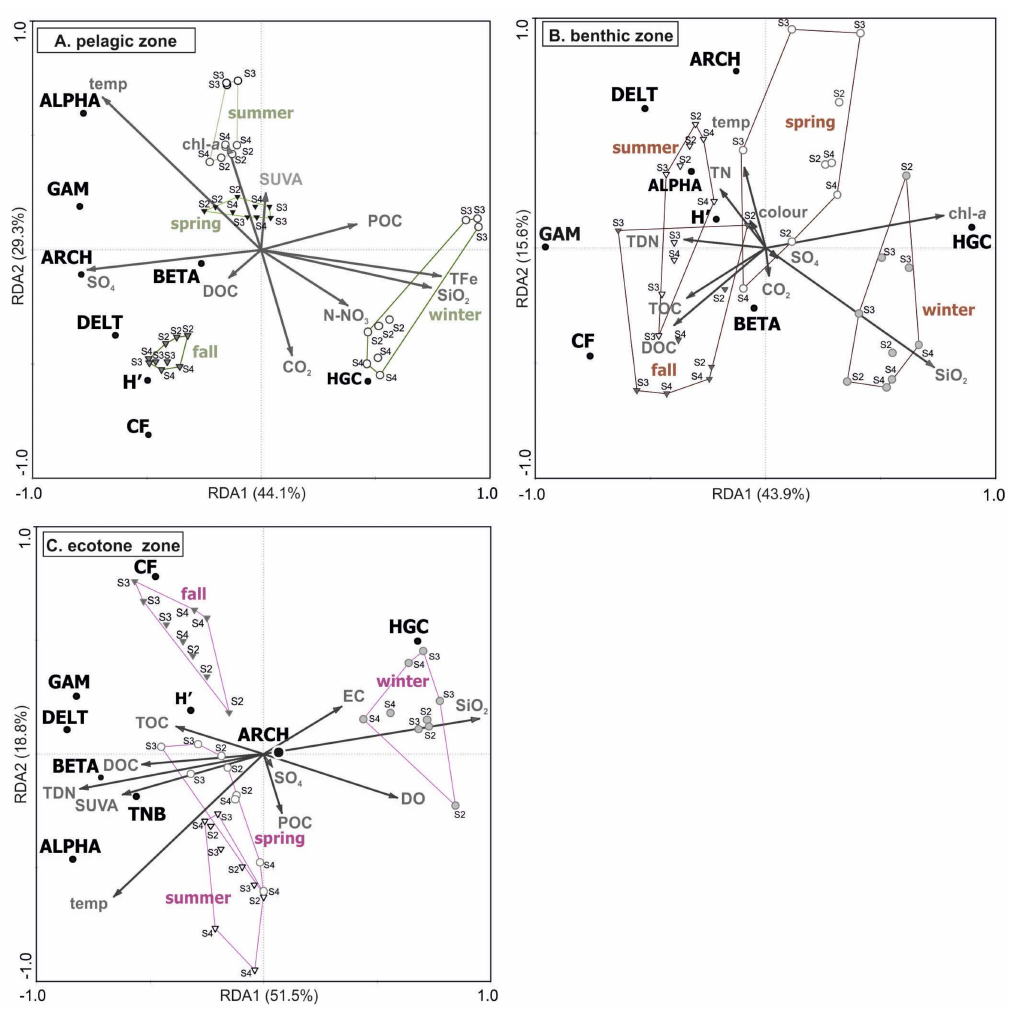
Figure 7. RDA biplots of physiochemical and microbiological parameters for the pelagic ( A ), benthic ( B ), and ecotone zones ( C ). Environmental variables are represented by arrows that approximately point towards the factor direction of maximum variation. The length of an arrow is proportional to the importance of that variable in the ordination. The angles between response (bacteria descriptors) and explanatory (environmental) variables in the RDA biplots reflect their correlations. Groups of samples represented a given season is marked in